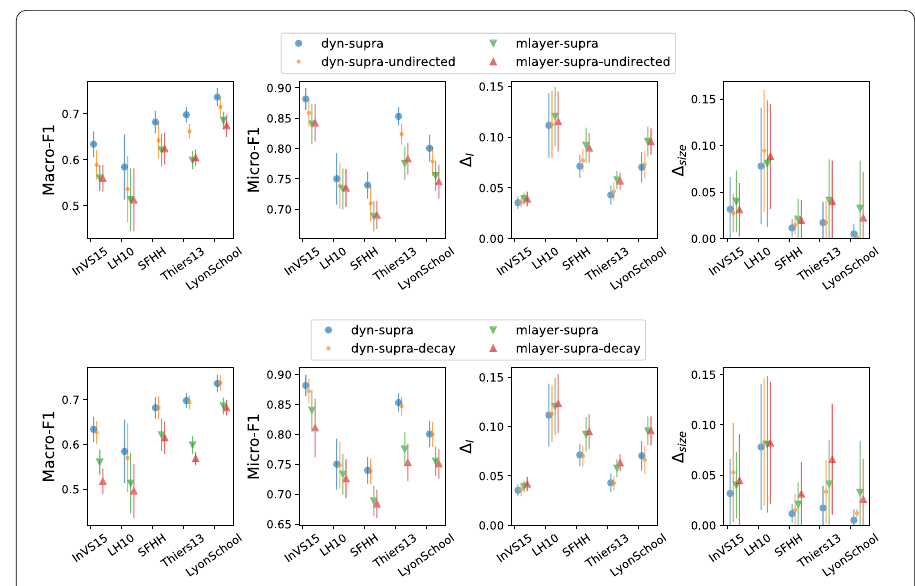
Figure 8 Effect of the variations in the supra-adjacency representation, for the DeepWalk embedding. Here ( β , μ ) = (0.13,0.055). Top: effect of using undirected edges. Bottom: effect of introducing weights depending on time difference. Bars indicate the standard